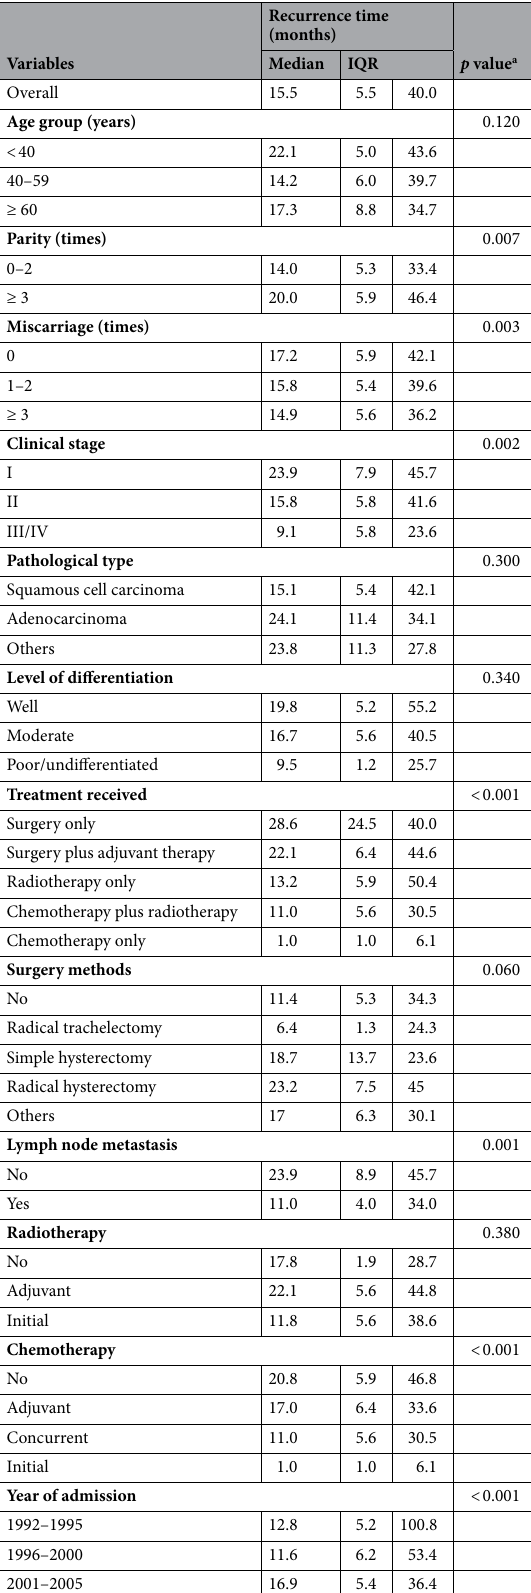
Table 2. Time to recurrence in the study population (N = 372). a p value was estimated using Log rank